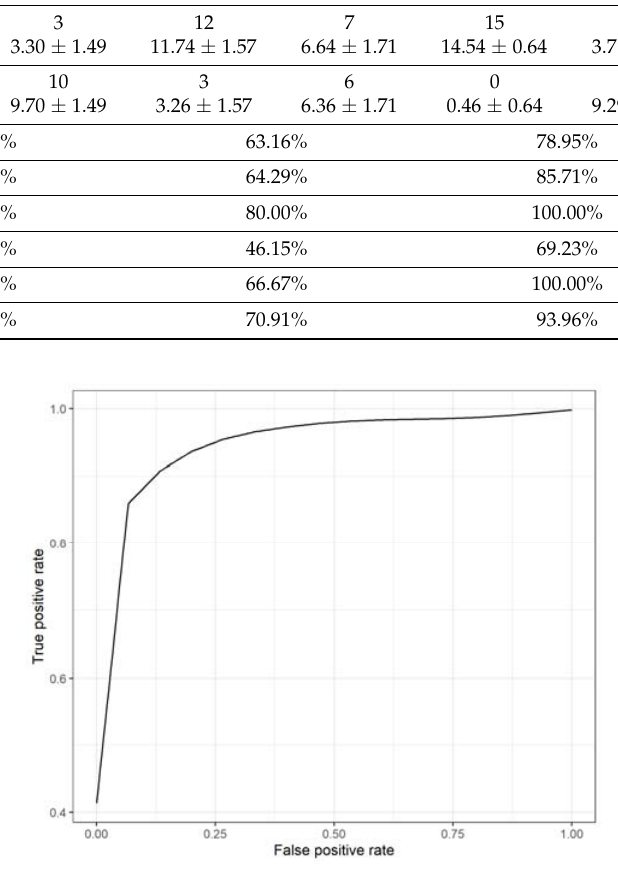
Figure 4. ROC curve for selected 10 serum and plasma biomarker combinations in the 10 times re ‐ peated 5 ‐ fold cross ‐ validation model.